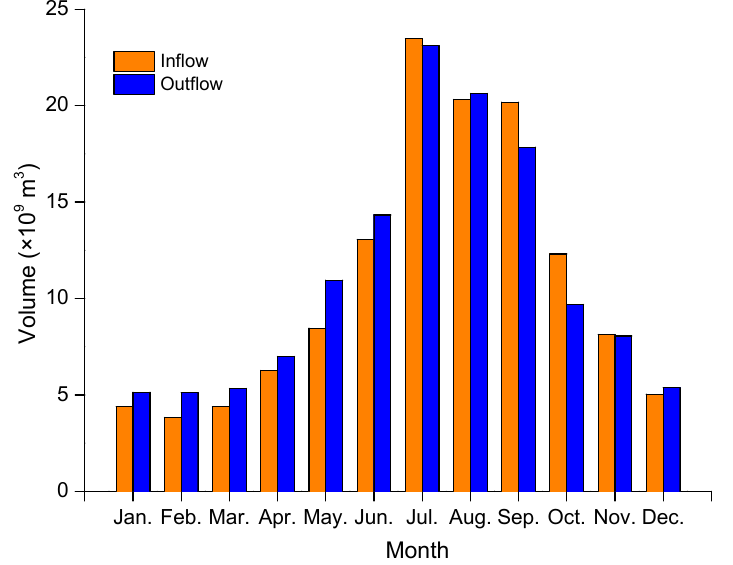
Figure 2. Monthly average inflow and outflow volumes of the TGR from 2005 to 2011.